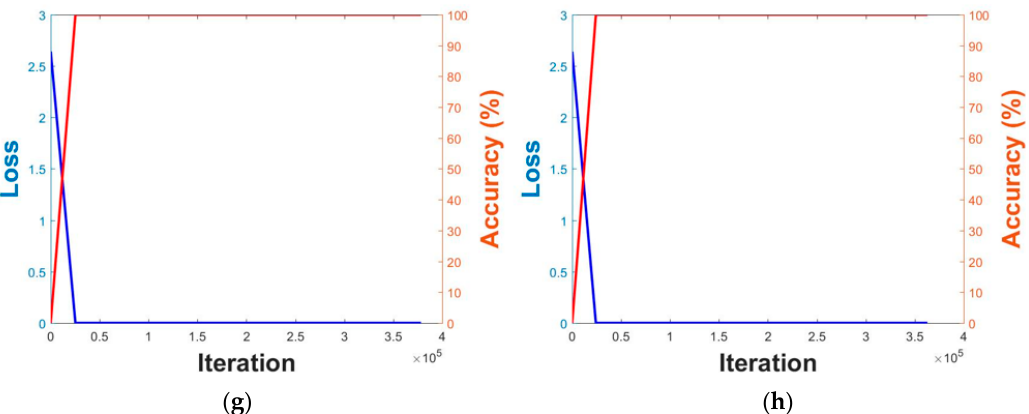
Figure 13. Graphs of training loss and accuracy on DFB-DB1 ( a – d ) and ChokePoint datasets ( e – h ). VGG Face-16 in case of ( a , e ) the 1st validation, ( b , f ) the 2nd validation. ResNet-50 in case of ( c , g ) the 1st validation, ( d , h ) the 2nd validation. Red and blue lines show the training accuracy and loss, respectively.